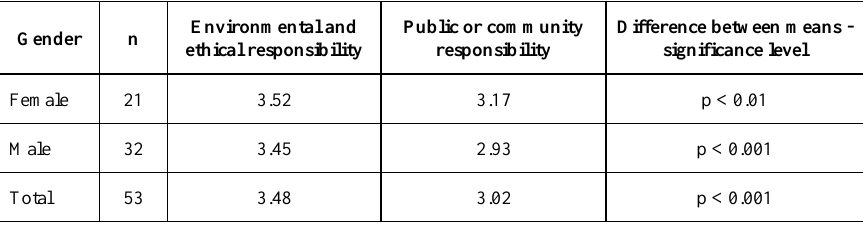
Table 1. Average response, by gender, for the environmental and ethical responsibility